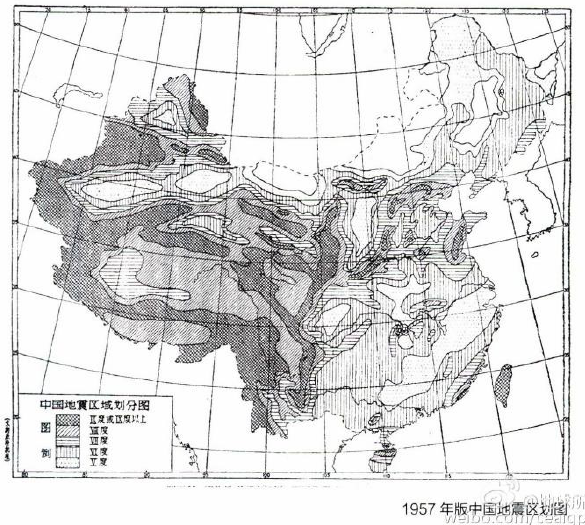
Figure 7. The 1957 version of the national earthquake zoning map for China. (Source: Institute of Geophysics, China Earthquake Ad-